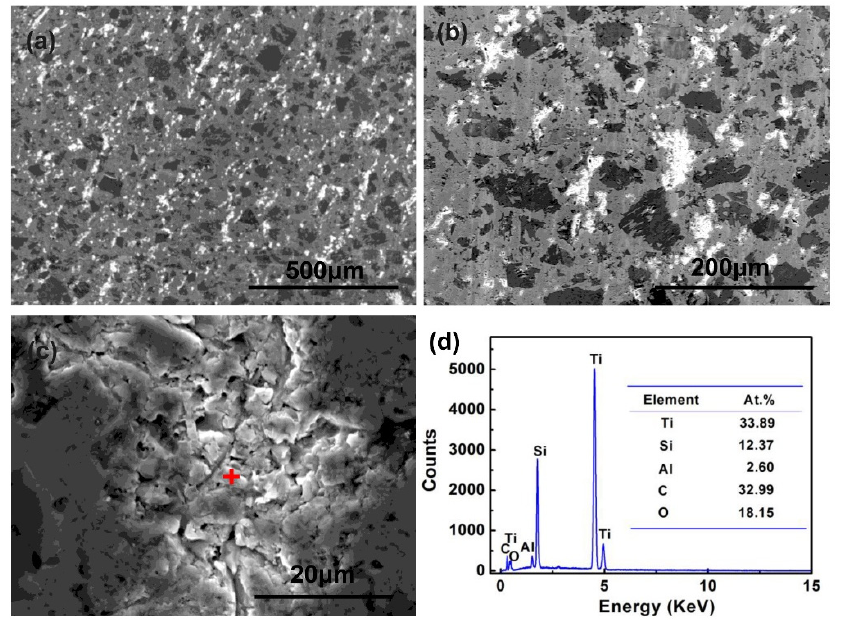
Figure 12. ( a – c ) SEM images of SiC ceramic infiltrated at 1000 ◦ C for 4 h with different magnifications, and ( d ) EDS analysis of the point in ( c ).